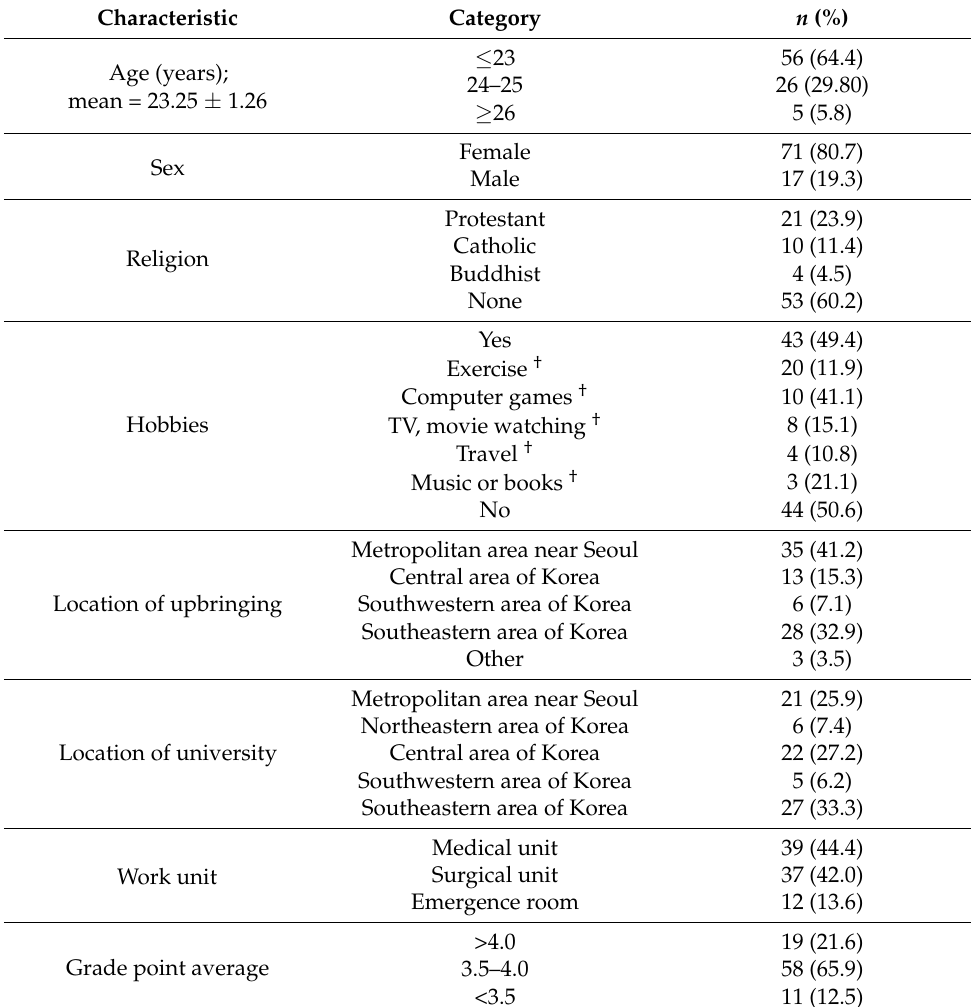
Table 1. Participants’ general characteristics ( N =